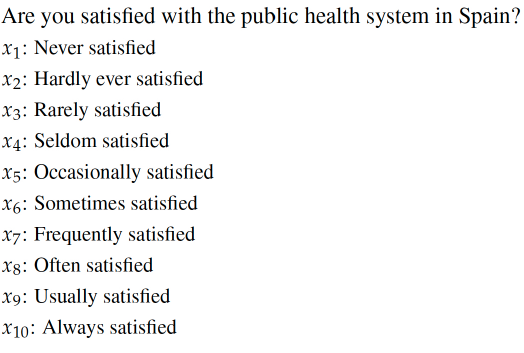
Figure 3. Question 2 under